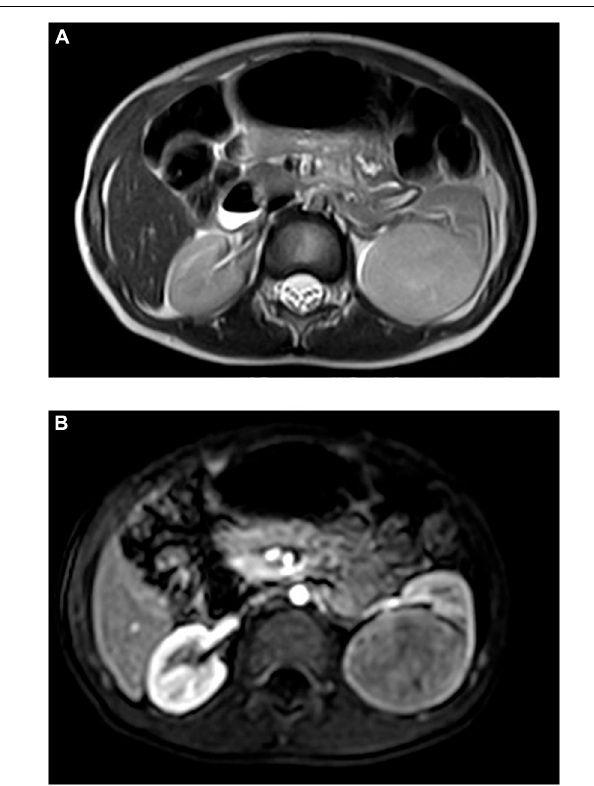
FIGURE 3 | (A) CT plain scan after chemotherapy: CT value was 43HU. (B) CT enhanced after chemotherapy: the third stage showed obvious uneven enhancement, with CT values of about 63HU, 101HU, and 135HU, respectively.